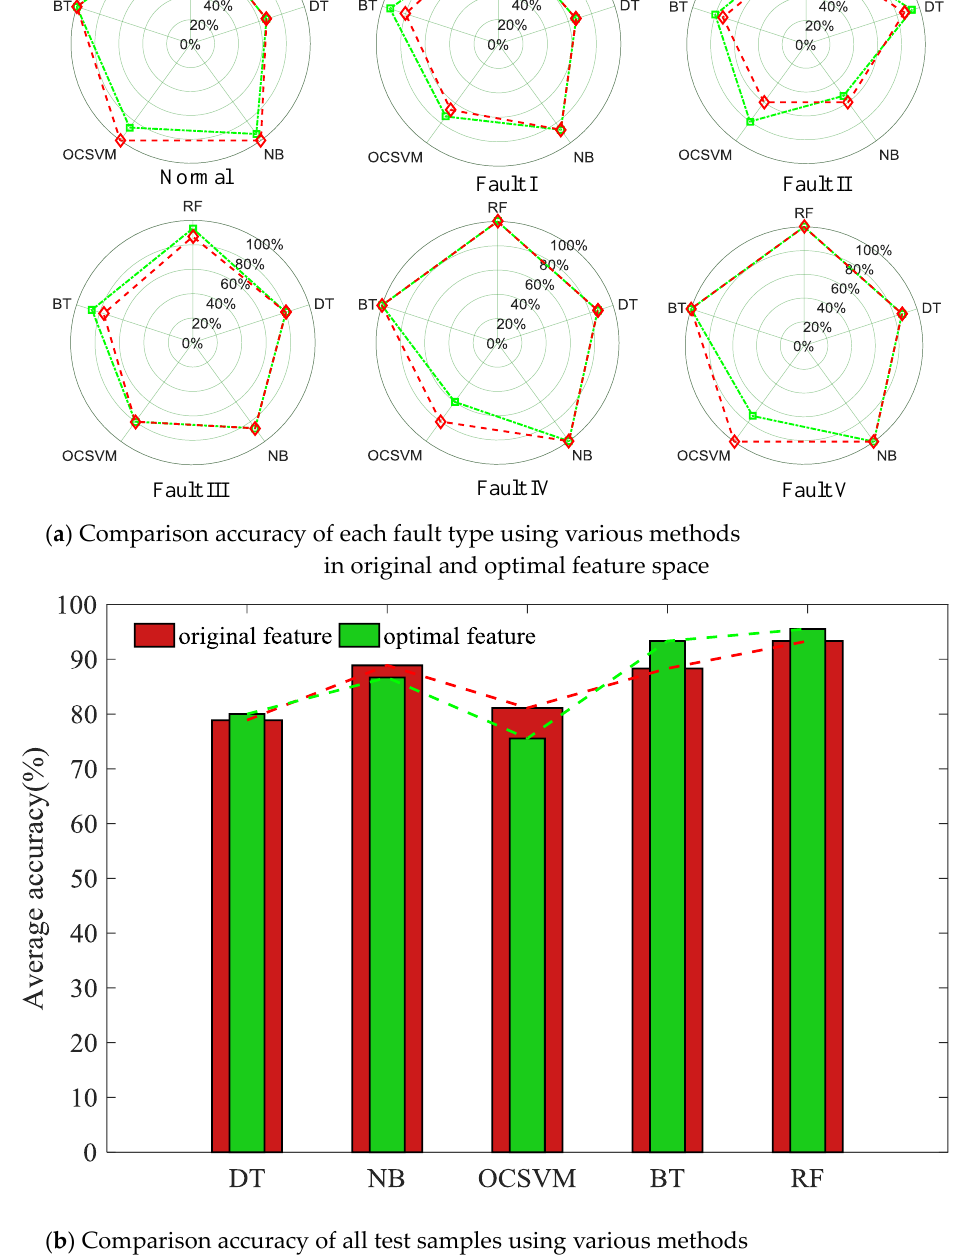
Figure 12. Diagnosis results after feature space optimization.